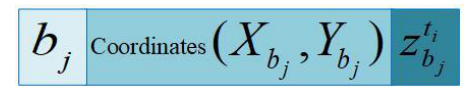
Figure 3. Distance measurement.